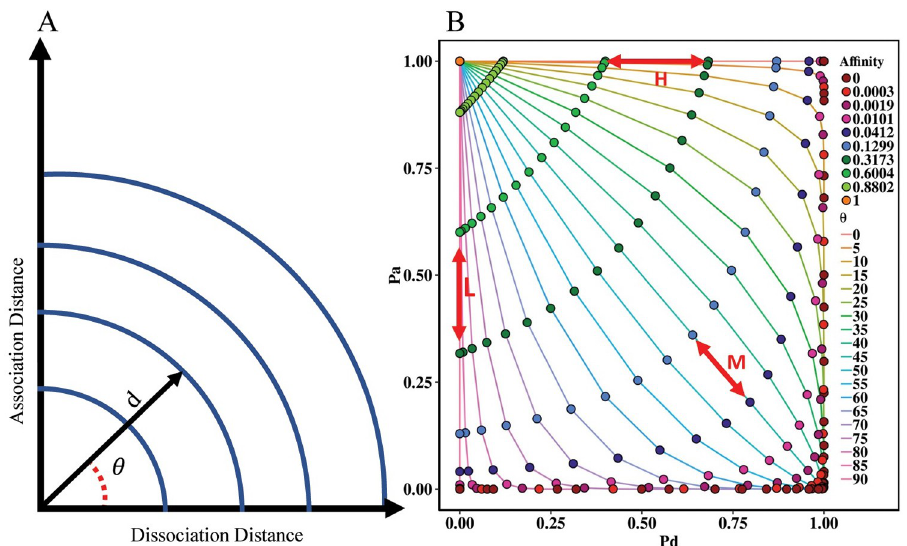
Fig 5. Correlation between P a , P d , affinity and Θ plotted for discrete affinity and Θ values. (A) Schematic of correlation between distance d in the shape-space and the corresponding association and dissociation distances defined by Θ . The blue iso-affinity curves denote combinations of distances that result in identical affinities. (B) The correlation between P a -P d and affinity of CC in the shape-space. Red arrows represent the three clones defined by different Θ values. SHM moves cells from each clone along the lines that represent specific Θ values resulting in lower or higher affinities (represented by the points). Affinities below 0.0003 are considered as 0.